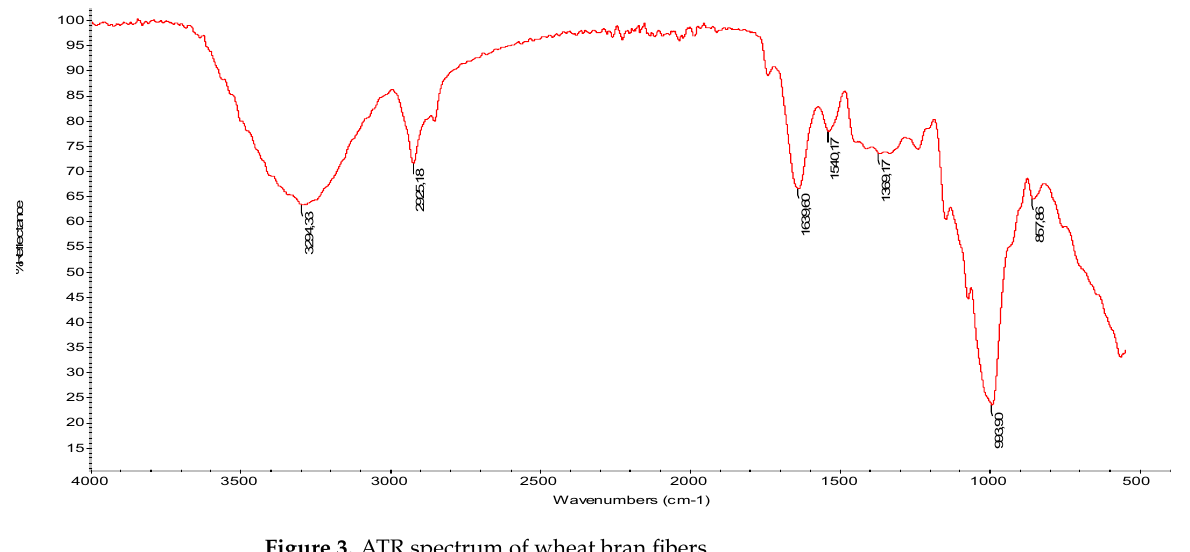
Figure 3. ATR spectrum of wheat bran fibers.